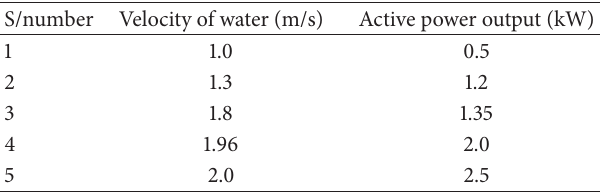
Table 1: Variation of output power with velocity of water.